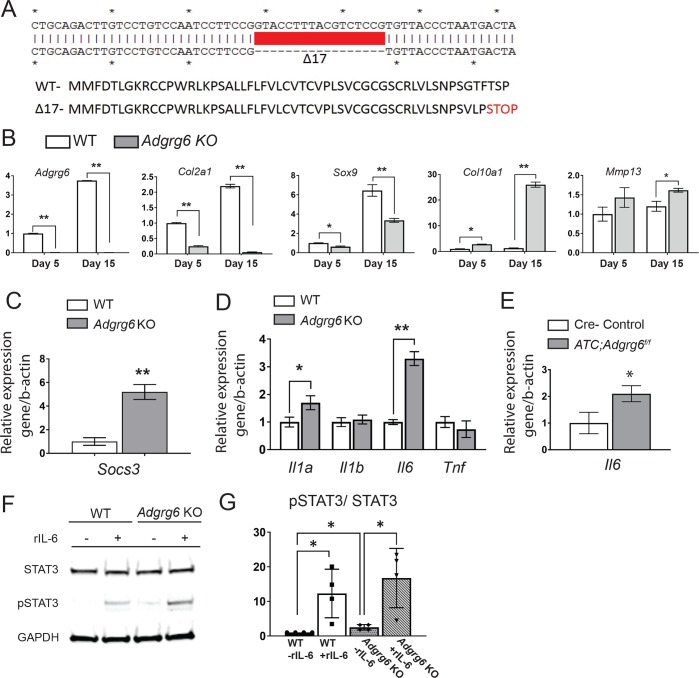
Adgrg6 regulates gene expression profiles and STAT3 signaling in ATDC5 cell culture.(A) Schematic of a 17-bp deletion of Adgrg6 from a stable single cell clone of ATDC5 cell line (Adgrg6 KO). (B) qPCR analyses of gene expression in ATDC5 cells at 5 and 15 days of maturation demonstrates decreased expression of markers of healthy disc, Col2a1and Sox9, and increased expression of the hypertrophic marker, Col10a1 and the extracellular matrix modifying enzyme, Mmp13 in Adgrg6 KO cells. (C) qPCR analyses revealed increased expression of Socs3 in Adrgr6 KO cells after 15 days of maturation. (D) qPCR analysis of Il1a, Il1b, Il6 and Tnf in ATDC5 cells maturated for 15 days. (E) qPCR analysis of Il6 expression in 1.5-month-old primary mouse IVDs (induced from E0.5-P20). (B-E, n = 3 biological replicates and representative result is shown. Bars represent mean ± SD. *p≤0.05, **p≤0.01, two-tailed Student's t Test). (F) Representative Western blot of wild type and Adgrg6 KO ATDC5 cell lysates showing stimulation of pSTAT3 staining after treatment with recombinant IL-6 (rIL-6) protein in both cell lines, while Adgrg6 KO cells show a mild constitutive stimulation of pSTAT3 without addition of rIL-6 (n = 4 biological replicates and representative result is shown). (G) Densitometry of the Western blot of wild type and Adgrg6 KO ATDC5 cell with or without IL-6 (rIL-6) treatment. (Each dot represents one biological replicate. Bars plot with mean ± SD. *p≤0.05, two-tailed Student's t Test.)